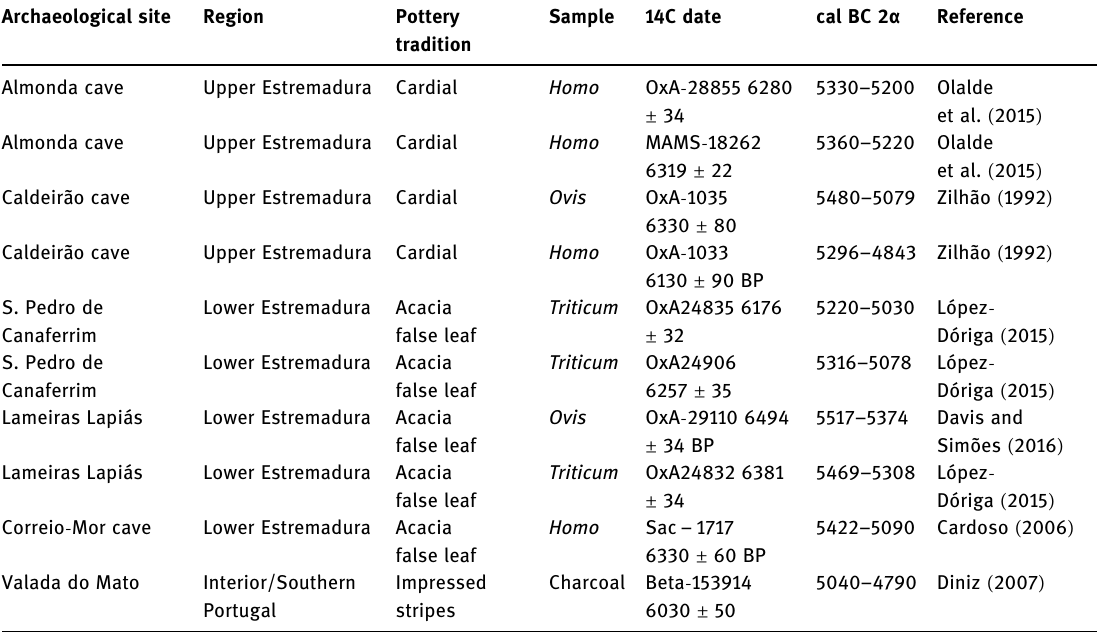
Table 1: Chronological framework for Early Neolithic pottery styles Archaeological